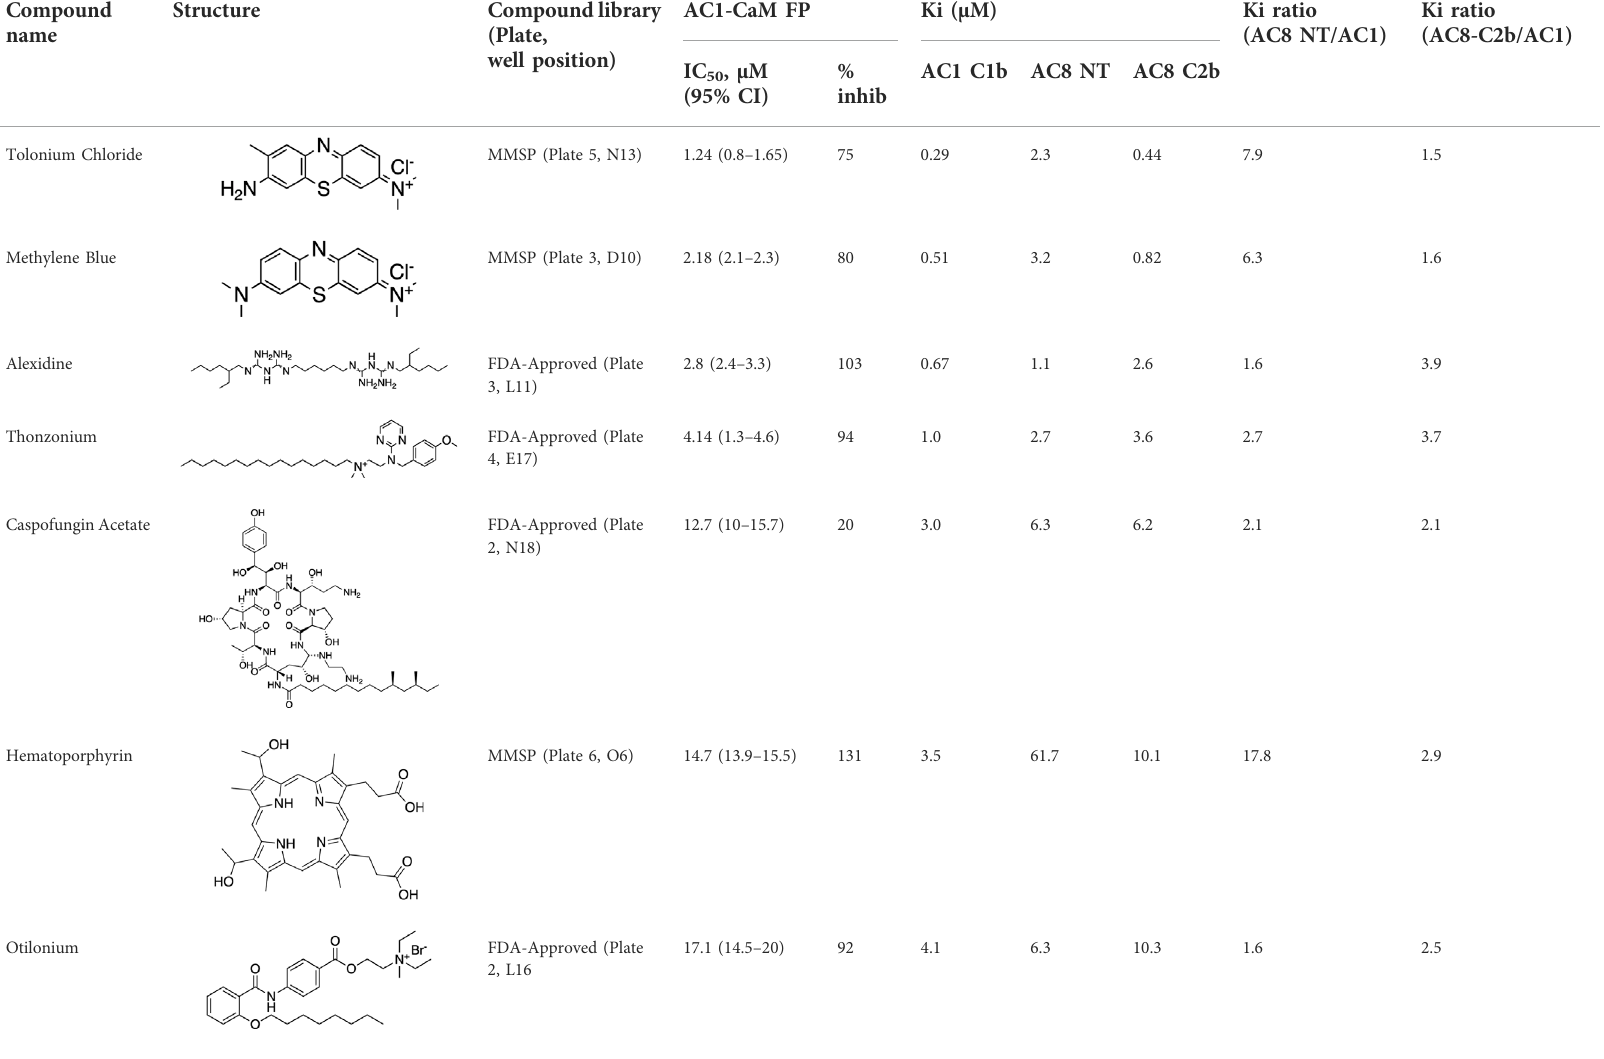
TABLE 3 AC1/CaM pilot screen CRC analysis. IC 50 and % inhibition relative to 100 μ M CDZ (100% inhibition) obtained for each compound in the AC1/CaM FP assay. The Ki values obtained with experimentallydeterminedK D valuesforeachAC/CaMFPassayandtheIC 50 valuesobtainedforeachcompoundinthedesignatedAC/CaMFPassay.The fi naltwocolumnsshowtheK i ratiosobtained for either AC8-Nt/CaM or AC8-C2b/CaM over AC1/CaM. Values with K i ratios greater than 1 were more potent in the AC1/CaM FP assay over the designated AC8/CaM FP assay. All data represents n = 3 experiments, ± CI for AC1/CaM IC 50